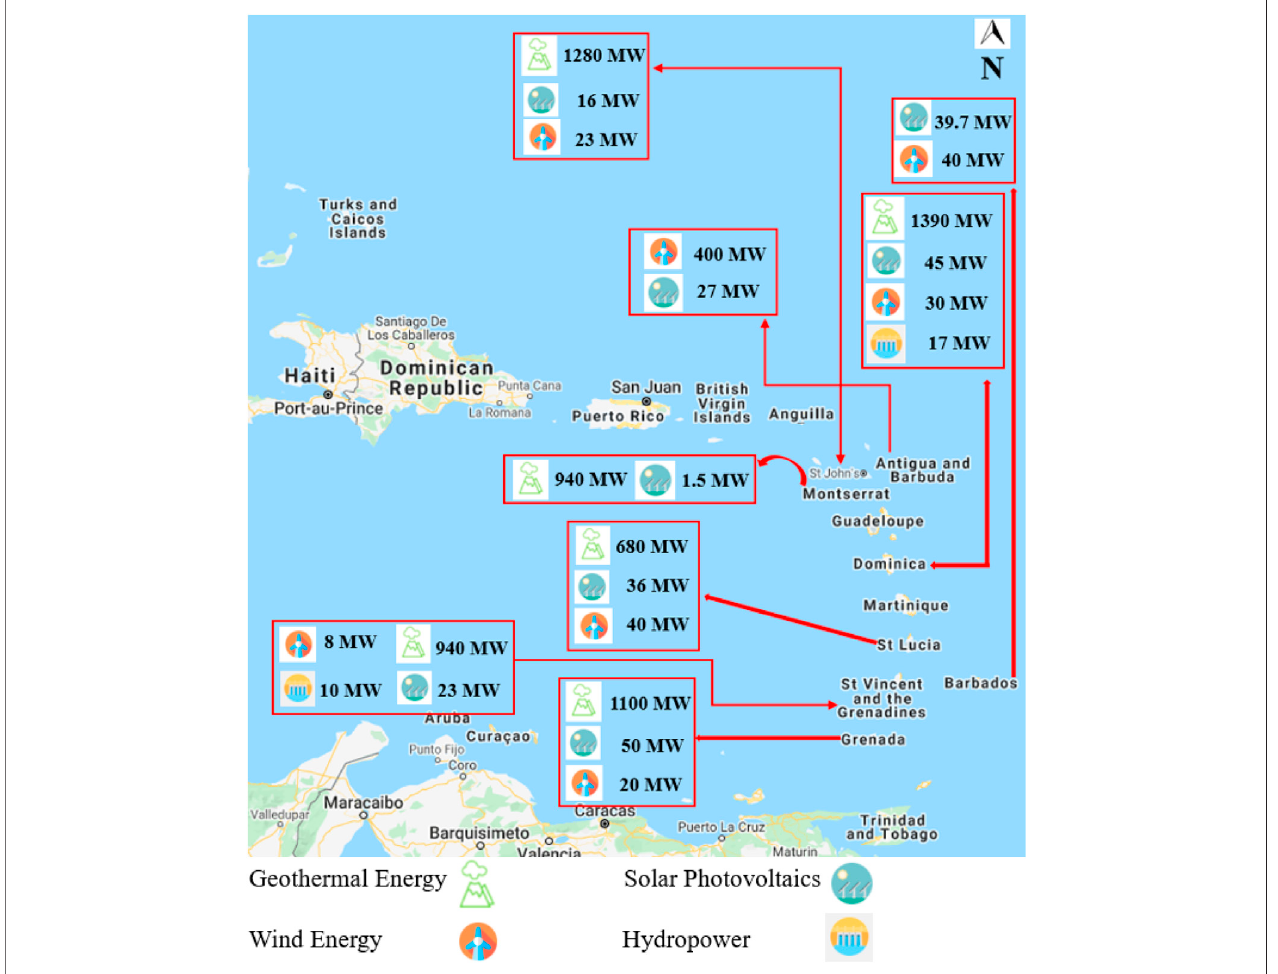
FIGURE 1 | Renewable energy potential comparison across the Eastern Caribbean nations (Source: Ochs, et al., 2015).